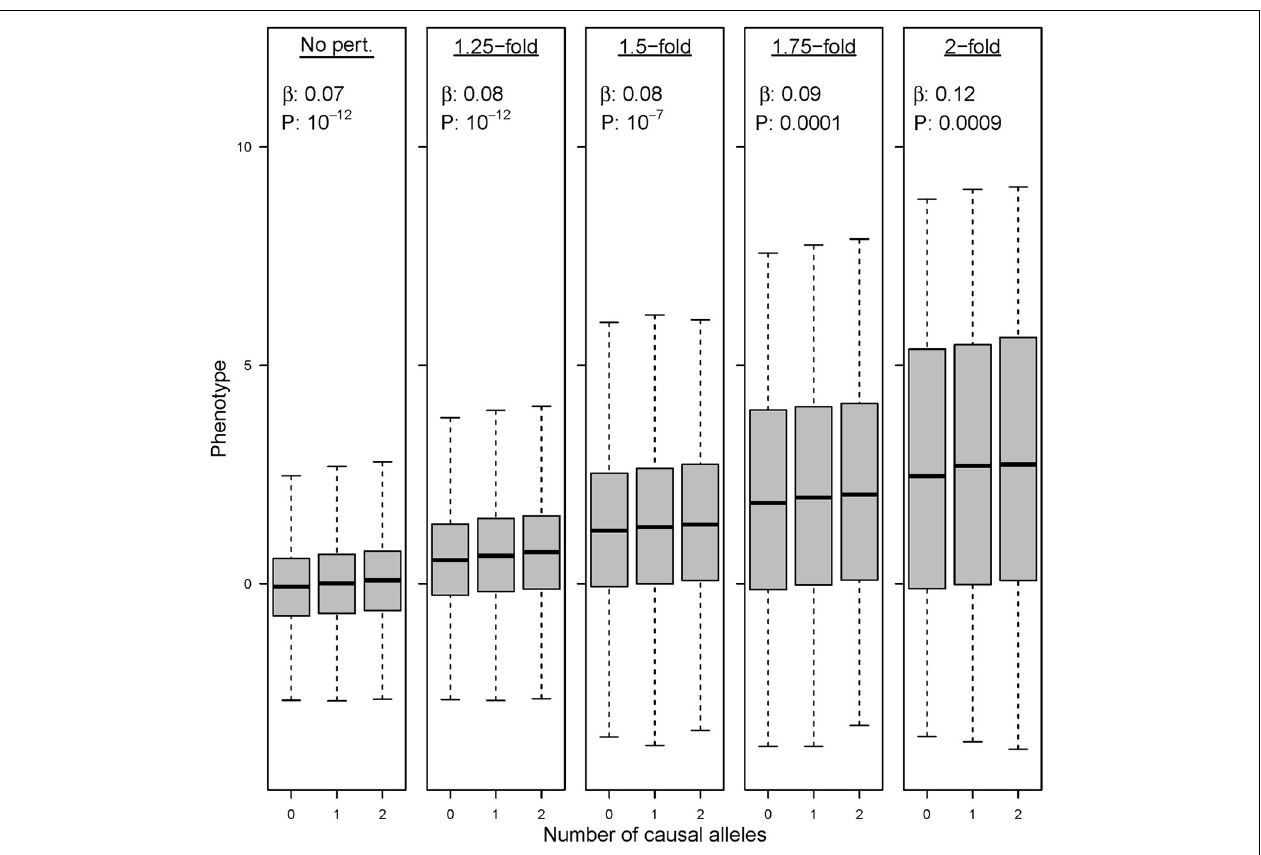
FIGURE 8 | Environmental perturbation in genetic effect sizes decreases the power of GWAS. Association results and P -value for the same variant under five different GWAS with 20,000 individuals. Left boxplot: a variant explaining 0.3% of the phenotypic variance achieves genome-wide